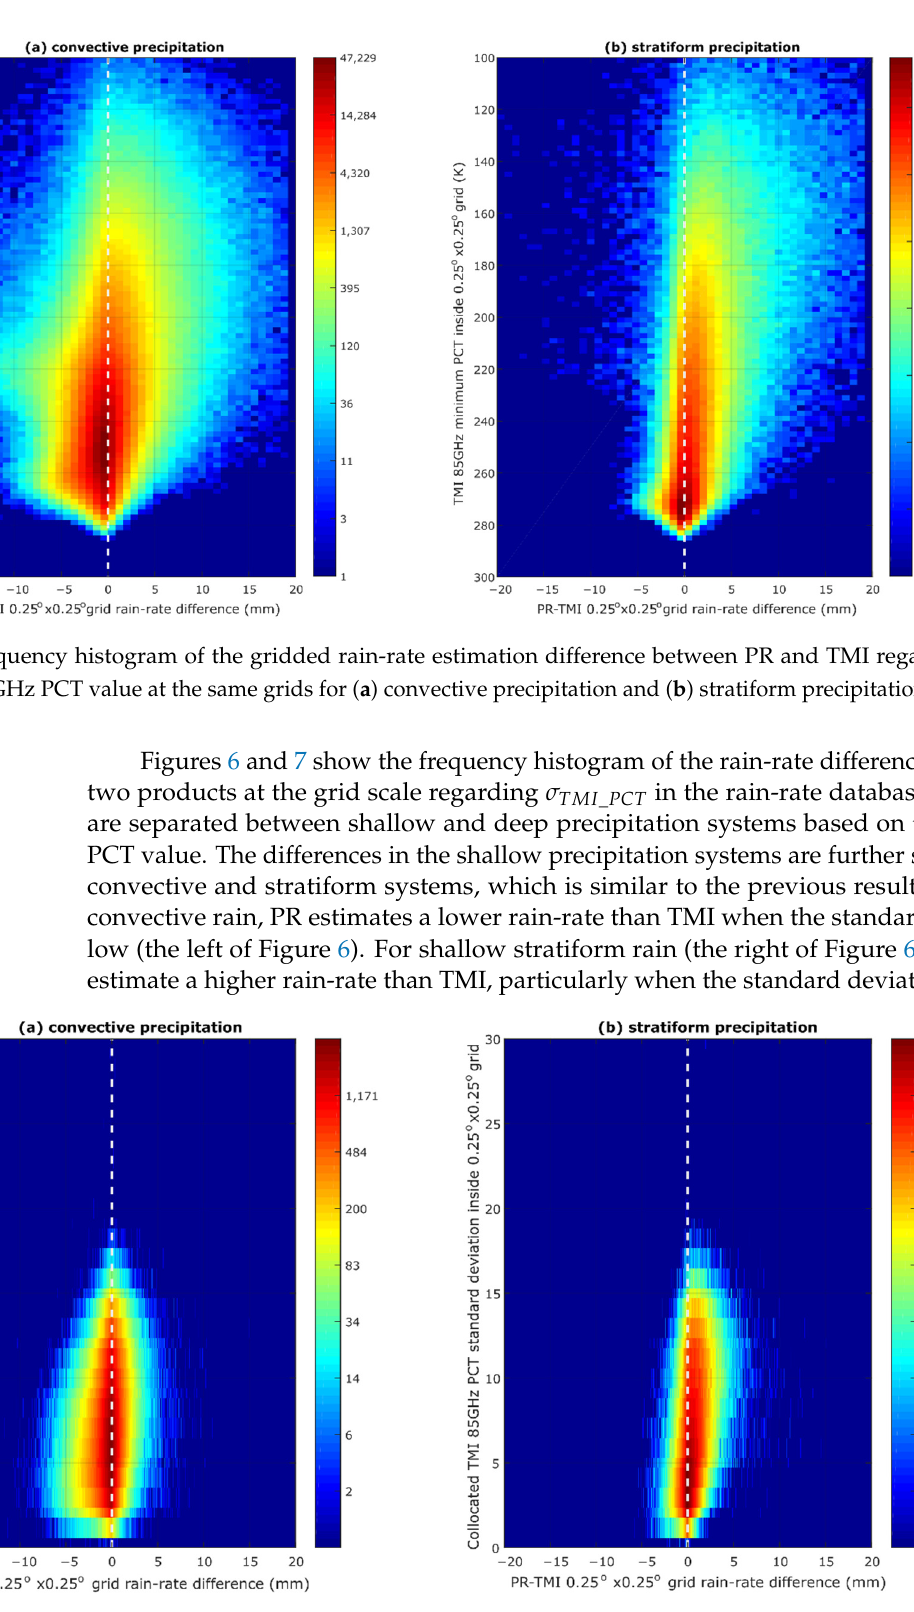
9 of 16 Table 2. Difference in the statistical characteristics of gridded TMI 85 GHz PCT standard deviation, PR convective fraction, and minimum TMI 85 GHz PCT for deep precipitation system based on fraction of number of TMI 85 GHz PCT below 273 K threshold (Source: data processing). 0.25° × 0.25° Grid